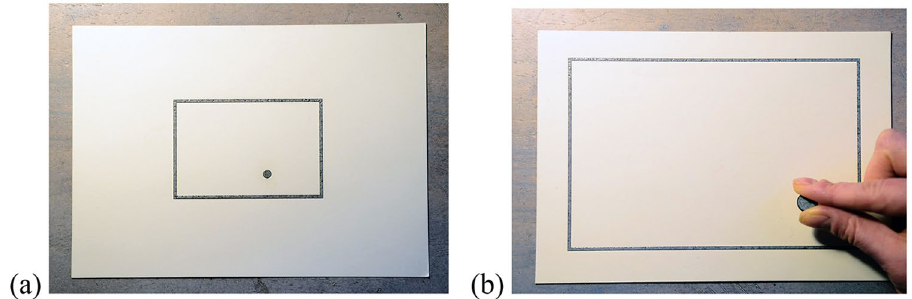
Figure 1. Example of a map for the scaling factor of 1:2 ( a ) and for giving the response in the reference space ( b ). The silver-grey elements of the boards are embossed.